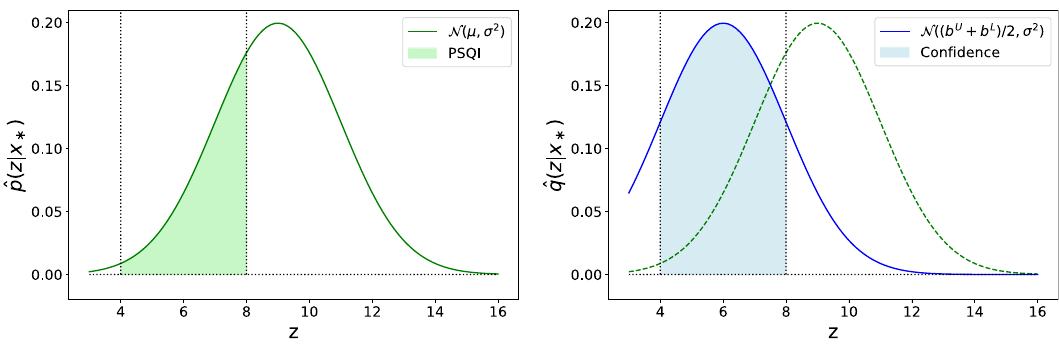
Figure 3. Example of PSQI (left) and confidence (right) calculation procedures for a single parameter. Dotted vertical lines denote admissible bounds b L and b U , green and blue solid lines denote obtained predictive distribution and its centered variant, respectively. Both PSQI and confidence values are calculated as the area under the respective distribution curves between the